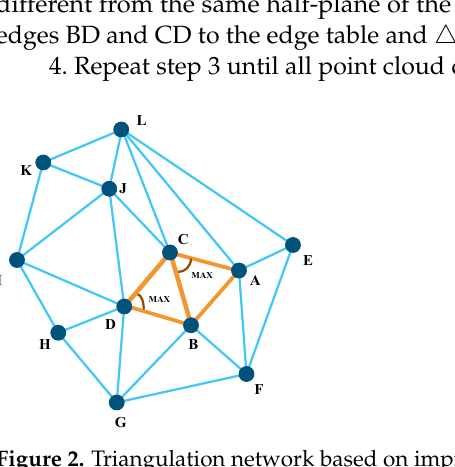
Figure 2. Triangulation network based on improved growth